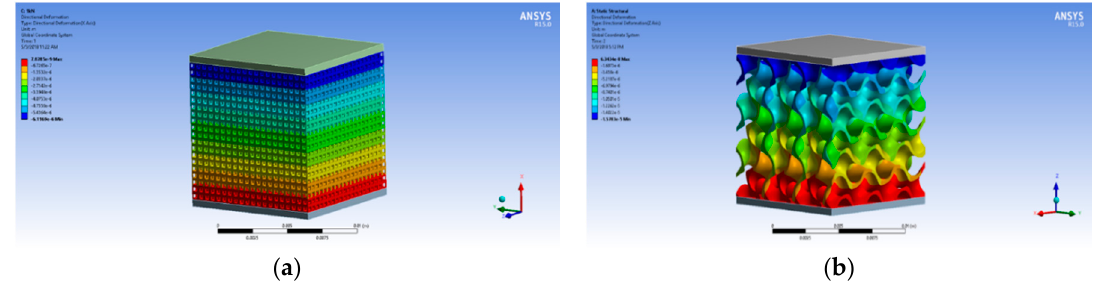
Figure 9. Deformation produced due to applied force in: ( a ) cubic sample; and ( b ) gyroid sample.